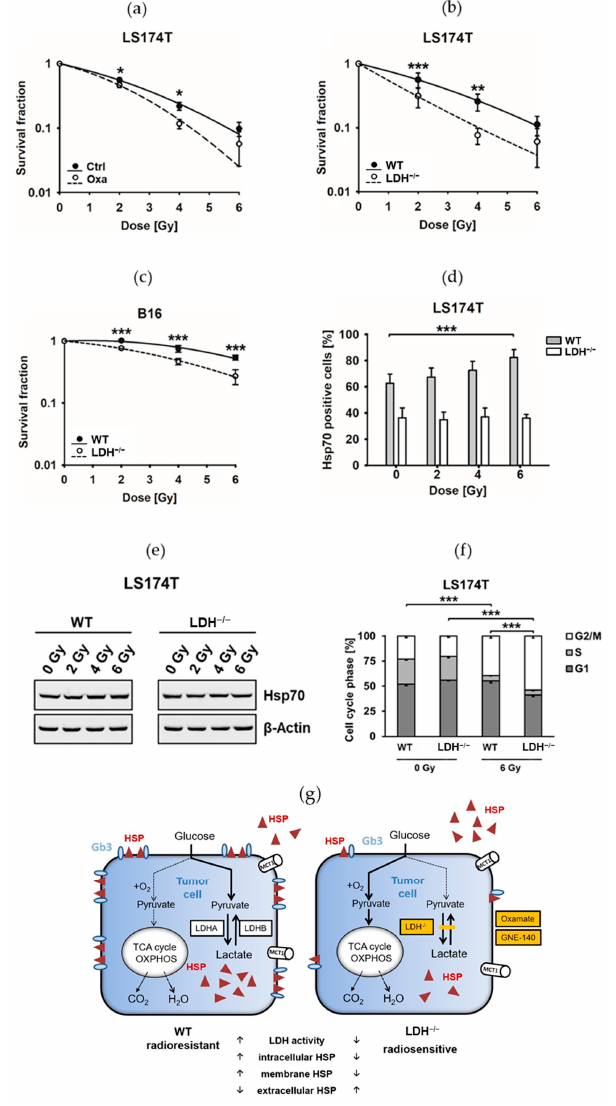
Figure 5. Inhibition of the LDHA/B activity significantly increases radiosensitivity in LS174T and B16F10 cells. ( a ) Colony-forming assay of untreated (Ctrl) and Oxa-treated LS174T cells after irradiation with 0 Gray (Gy, sham), 2 Gy, 4 Gy and 6 Gy (*: p ≤ 0.05). ( b,c ) Colony-forming assay of LS174T ( b ) and B16F10 ( c ) and wildtype (WT) and LDHA/B double knockout LDH − / − cells after irradiation with 0 Gy (sham), 2 Gy, 4 Gy and 6 Gy (**: p ≤ 0.01 and ***: p ≤ 0.001). ( d ) Percentage of LS174T